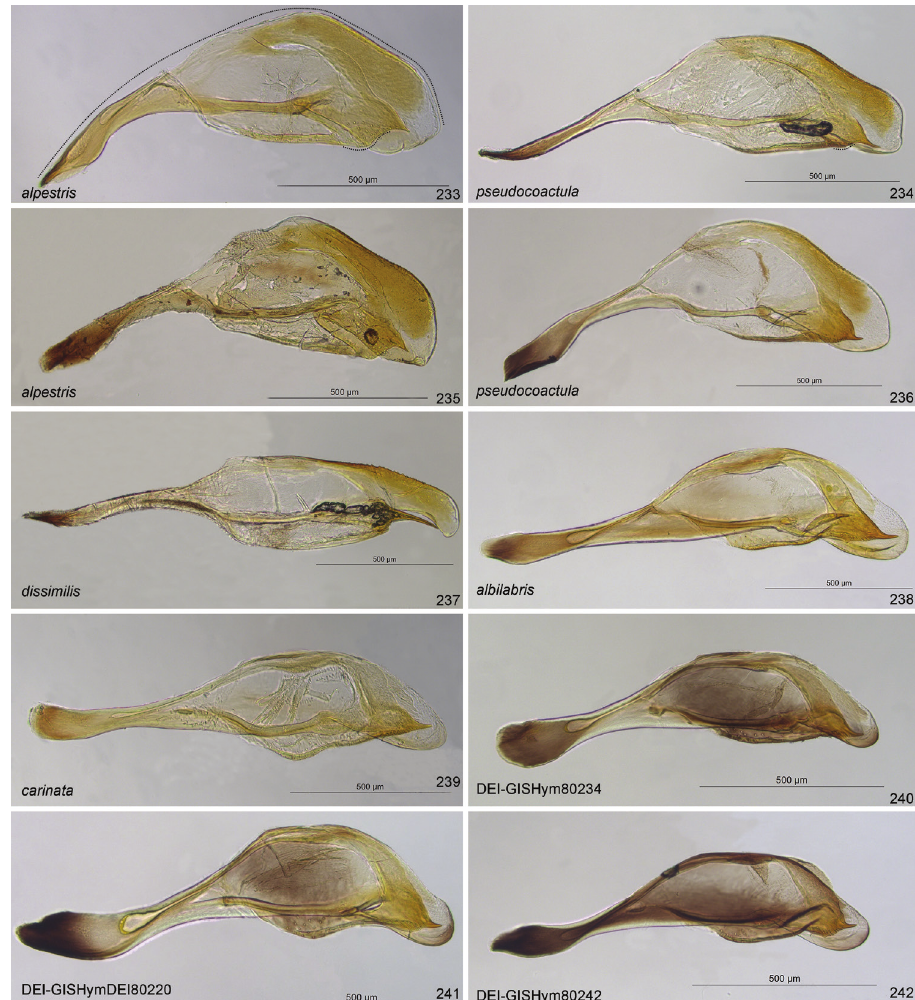
Figures 233–242. Penis valves of Pristiphora . 233 alpestris DEI-GISHym31711 234 pseudocoactula DEI-GISHym19968 235 alpestris , holotype of karvoneni 236 pseudocoactula DEI-GISHym80212 237 dissimilis holotype 238 albilabris DEI-GISHym80210 239 carinata syntype (GBIF-GISHym4689) 240 carinata group (DEI-GISHym80234) 241 carinata group (DEI-GISHym80220) 242 carinata group